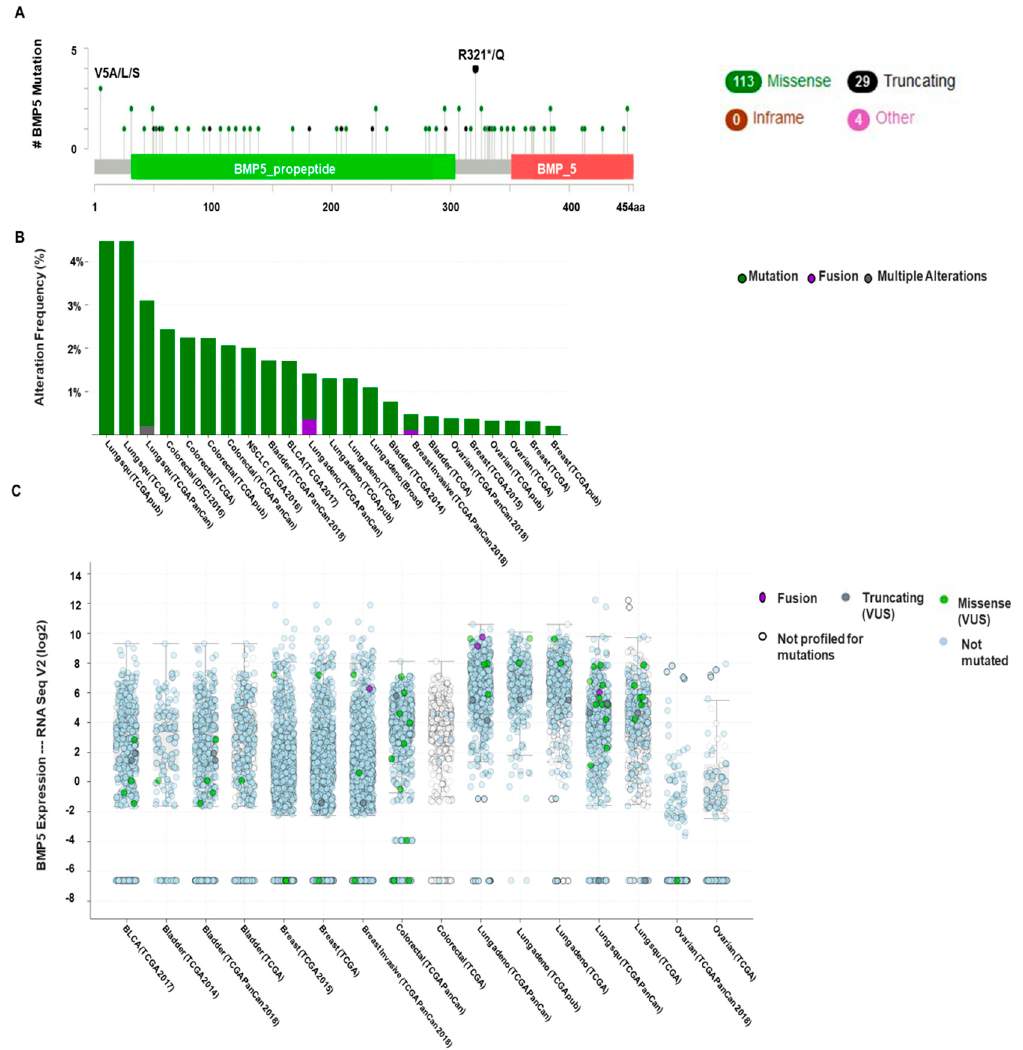
Figure 5. Frequency of mutations, copy number alterations (CNAs) and expression in various types of cancer derived from cBioPortal web. ( A , B ), Total 146 mutations were located within amino acids 1 to 454 of BMP5 . Highest mutations occurred in colorectal cancer, invasive breast cancer at R321*/Q amino acid (total 4 cases) followed by lung squamous carcinoma at V5A/L/S amino acid (total 3 cases). Mutation sites were located in a hotspot in BMP5 -propeptide and BMP5 domain. The highest alteration frequency was reported in lung squamous carcinoma datasets. Only datasets containing > 100 samples per cancer types are shown. The alteration frequency exhibited mutations (green), fusions (violet) and multiple alterations (grey). ( C ) BMP5 mRNA expression (RNA Seq V2) in 24 cancer studies generated from the cBioPortal web. Mutations were reported in bladder cancer, breast cancer, colorectal cancer, lung cancer and ovarian cancer. Highest mutated mRNA expression occurred in lung cancer (36 cases). The x-axis is divided according to the cancer types, and Y-axis represents BMP5 mRNA expression levels. The expression frequency exhibited missense mutations (green), fusions (violet), truncating (deep blue), no mutations (blue), and no profiled mutations (white). Table 1. data analysis of the BMP5 gene in three different cancer types derived from cBioPortal for Cancer Genomics . Number of Protein Mutation Mutation in Sample ID Cancer Type Dataset Change Type Sample